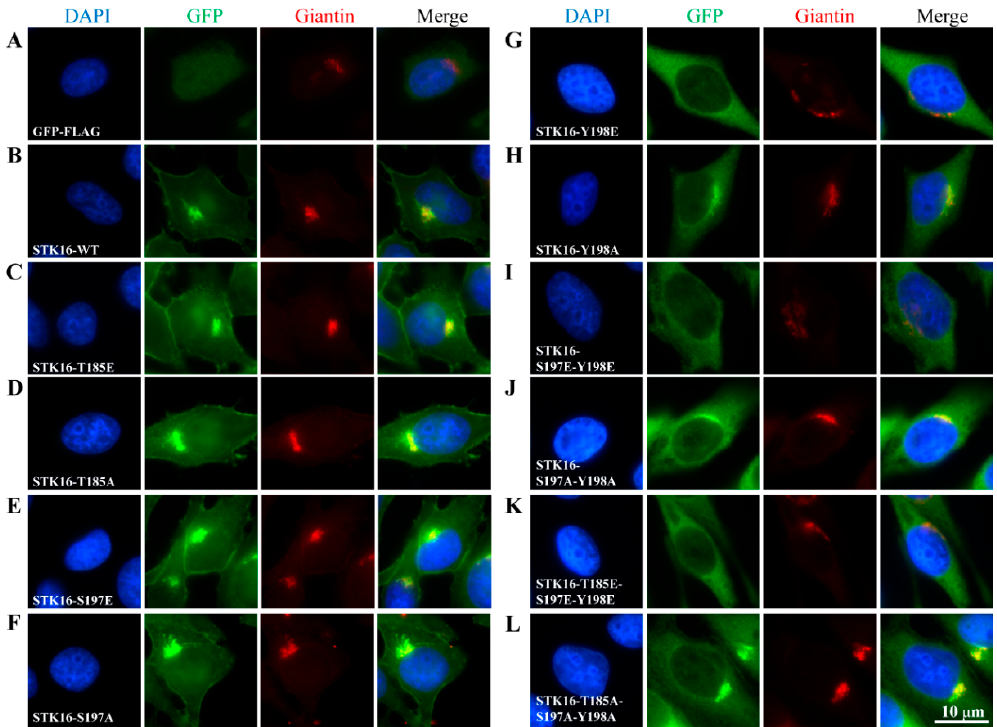
Figure 2. Effects of three autophosphorylation sites of STK16 on its subcellular localization. HeLa cells stably transfected with ( A ) GFP-FLAG, as well as GFP-FLAG tagged ( B ) STK16-WT, ( C ) STK16-T185E, ( D ) STK16-T185A, ( E ) STK16-S197E, ( F ) STK16-S197A, ( G ) STK16-Y198E, ( H ) STK16-Y198A, ( I ) STK16-2E (S197E and Y198E), ( J ) STK16-2A (S197A and Y198A), ( K ) STK16-3E (T185E, S197E, and Y198E), and ( L ) STK16-3A (T185A, S197A, and Y198A) were fixed and stained for GFP (green) and Giantin (red). DAPI staining of the nucleus is shown in blue. Experiments were repeated at least three times and representative results are shown. Scale bar, 10 μ m.